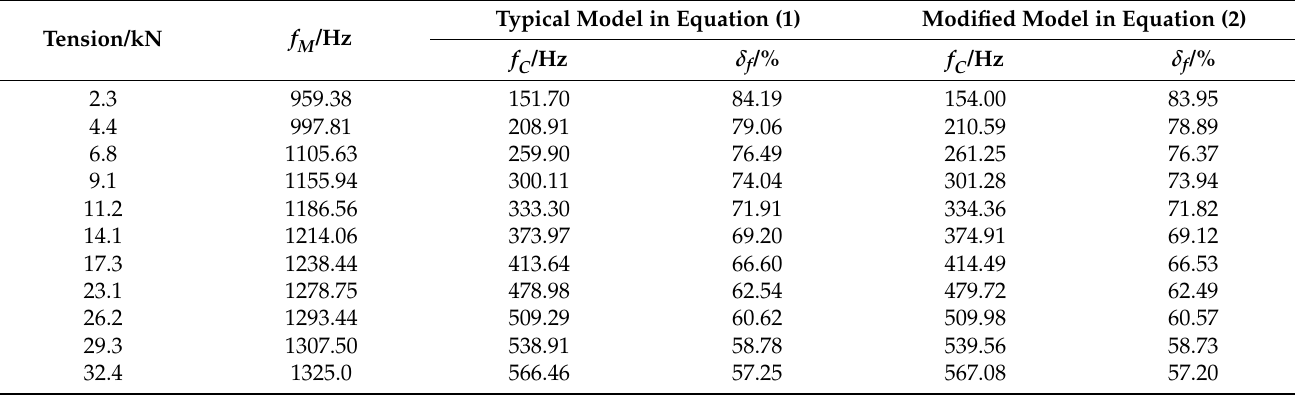
Table 2. First order vibration frequency of sample 1 under different tension